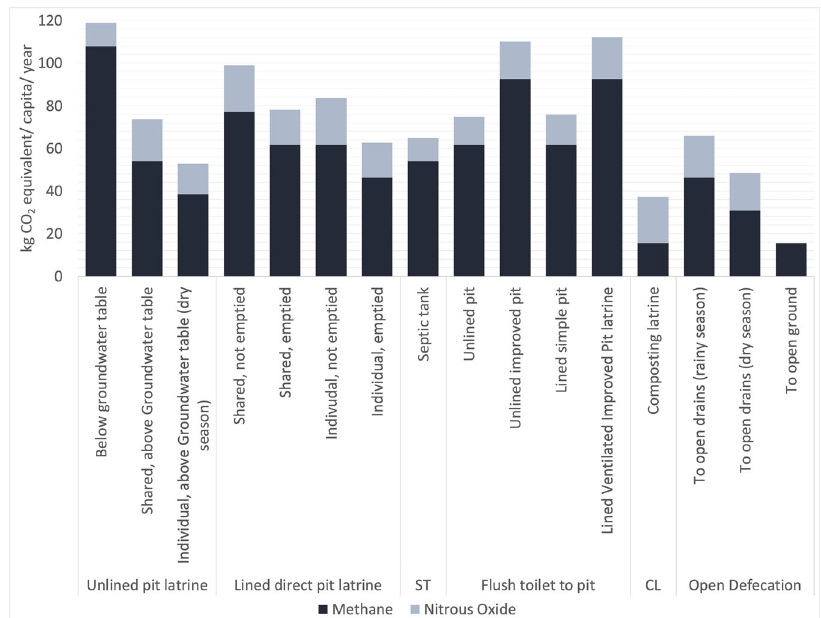
Fig. 2 Aggregate per-capita emission rates for typical sanitation containment systems in Kampala. Annual per-capita emissions of methane (black) and nitrous oxide (grey) expressed in kgCO 2 equivalent from containers (pits and tanks) in Kampala under observed operating conditions. Emissions rates were calculated using the IPCC method. Methane-correction factors and emissions factors were calculated using information about the extent of aerobic and anaerobic conditions observed inside containers by Nakagiri et al. 21 .